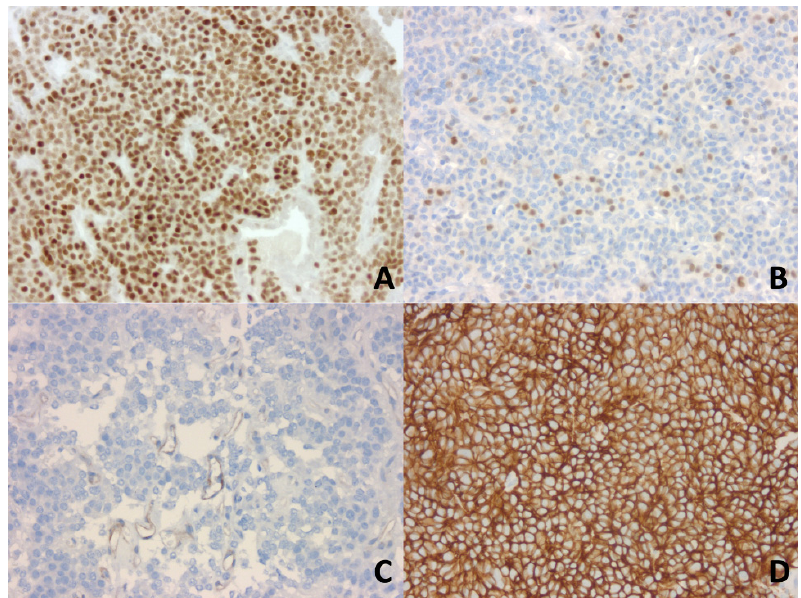
Figure 1. Immunohistochemical analysis of estrogen receptor alpha (ER α ) and of somatostatin receptor 2 (SST2) expression in gonadotroph tumors using the immunoreactive score (IRS). IRS is calculated as the percentage of positive nuclei (0 to 4) × the intensity of the staining (0 to 3) (original magnification, ×200). ( A ). IRS ER α = 12 in a FSH-LH tumor (strong nuclear immunoexpression in 95% of neoplastic cells). ( B ). IRS ER α = 2 in a FSH-LH tumor (moderately intense immunopositivity in 5% of neoplastic cells). ( C ). IRS SST2 is negative in this FSH-LH tumor (absence of immunopositivity in the neoplastic cells; faint vascular expression as a positive internal control). ( D ). IRS SST2 = 12 in a FSH tumor (strong membranous immunoexpression in 100% of neoplastic cells). Abbreviations: follicle-stimulating hormone (FSH), luteinizing hormone (LH).